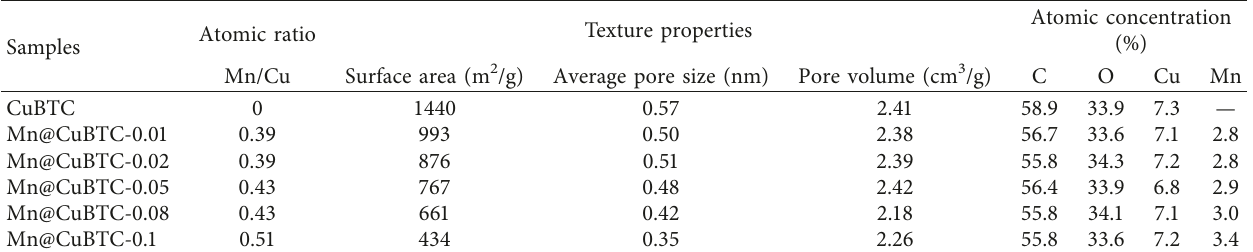
Table 1: Texture properties and relative elemental composition of CuBTC and Mn@CuBTC-X.